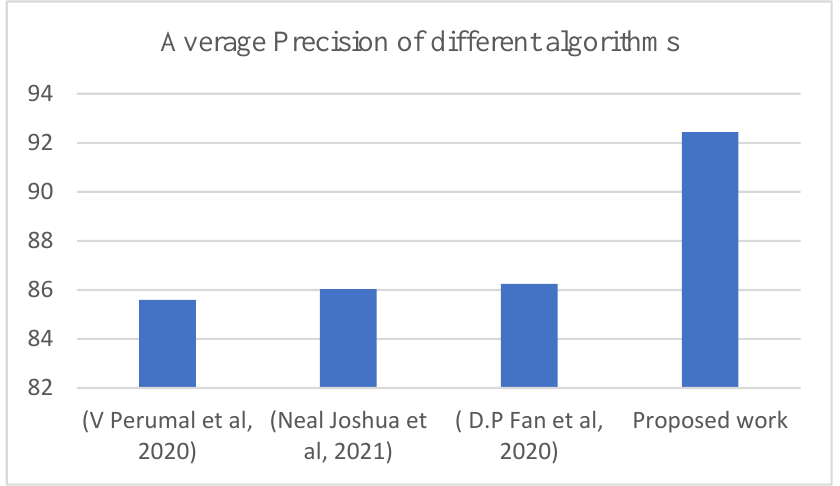
Figure 12. Average precision for different algorithms from [7,19,28], and proposed work. Table 3. Test recall for combined